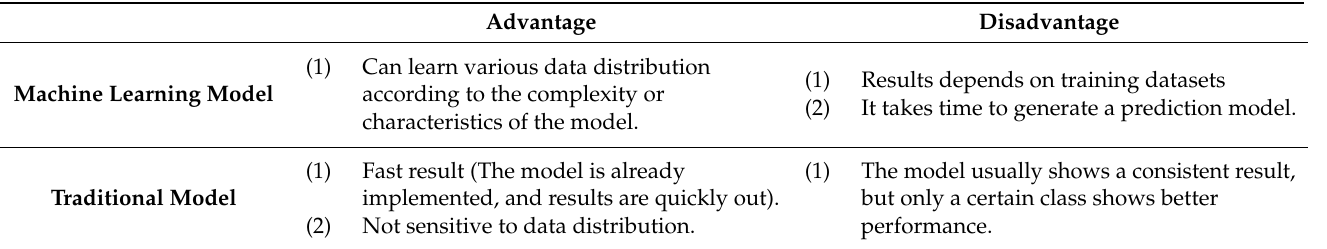
Table 2. Difference between machine learning model and traditional model.